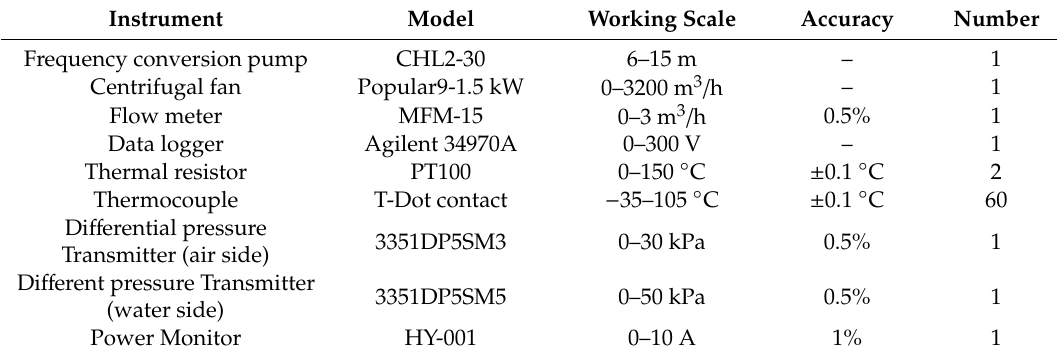
Table 1. Information of experimental instruments.